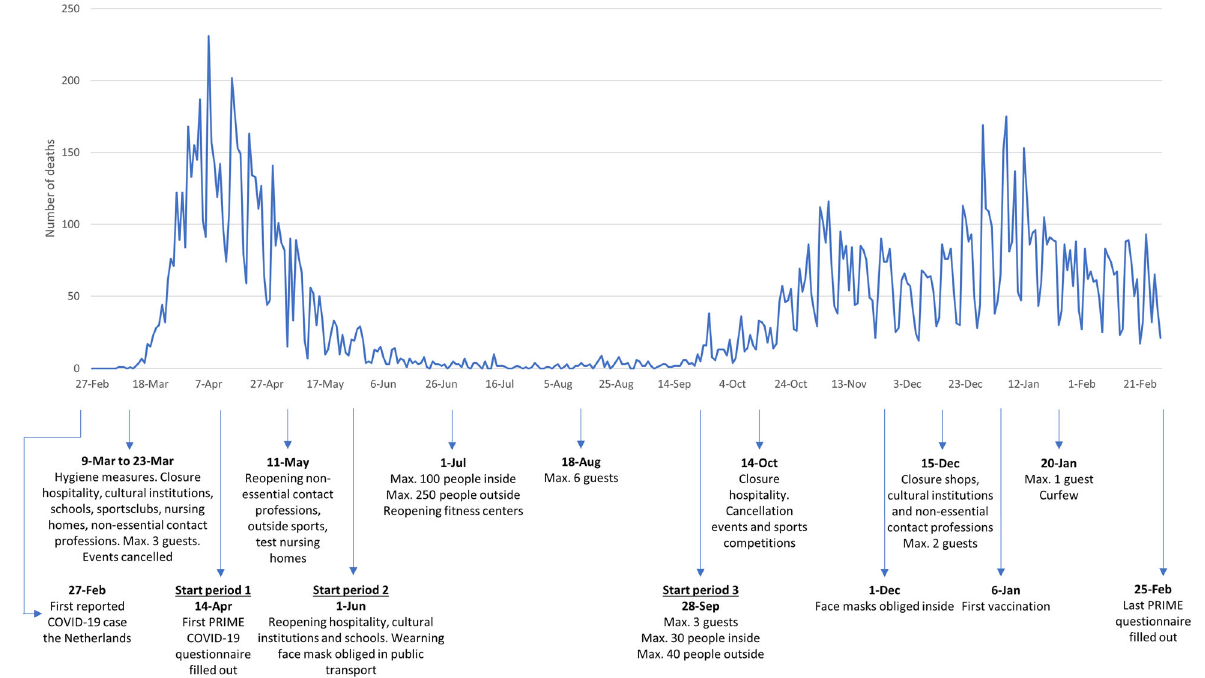
Fig. 5 Timeline of COVID-19 related deaths and restrictions in the Netherlands. Data derived from: https://data.rivm.nl/covid-19/ and